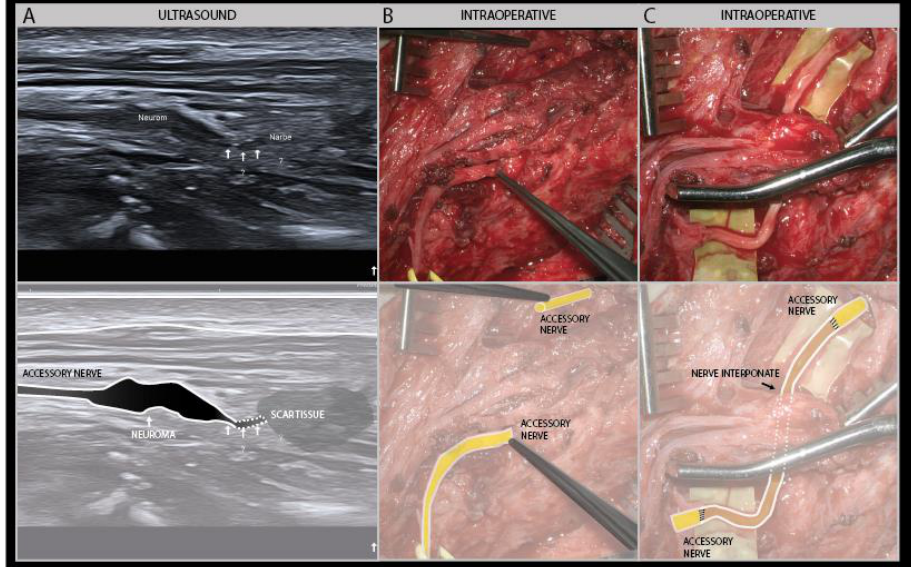
Figure 15. Seventeen-year-old boy with a car accident and injury to the neck due to broken glass shards. There was a complete paresis of the trapezius muscle; and the nerve ultrasound of the accessory nerve showed a neuroma without nerve continuity (high-frequency of 19–24 MHz) ( A ). Intraoperative images show a complete sharp transection injury of the accessory nerve without continuity ( B ). Another intraoperative image after placement of a nerve interponate ( C ) (these intraoperative images were kindly provided by Prof. Dr. G. Antoniadis).